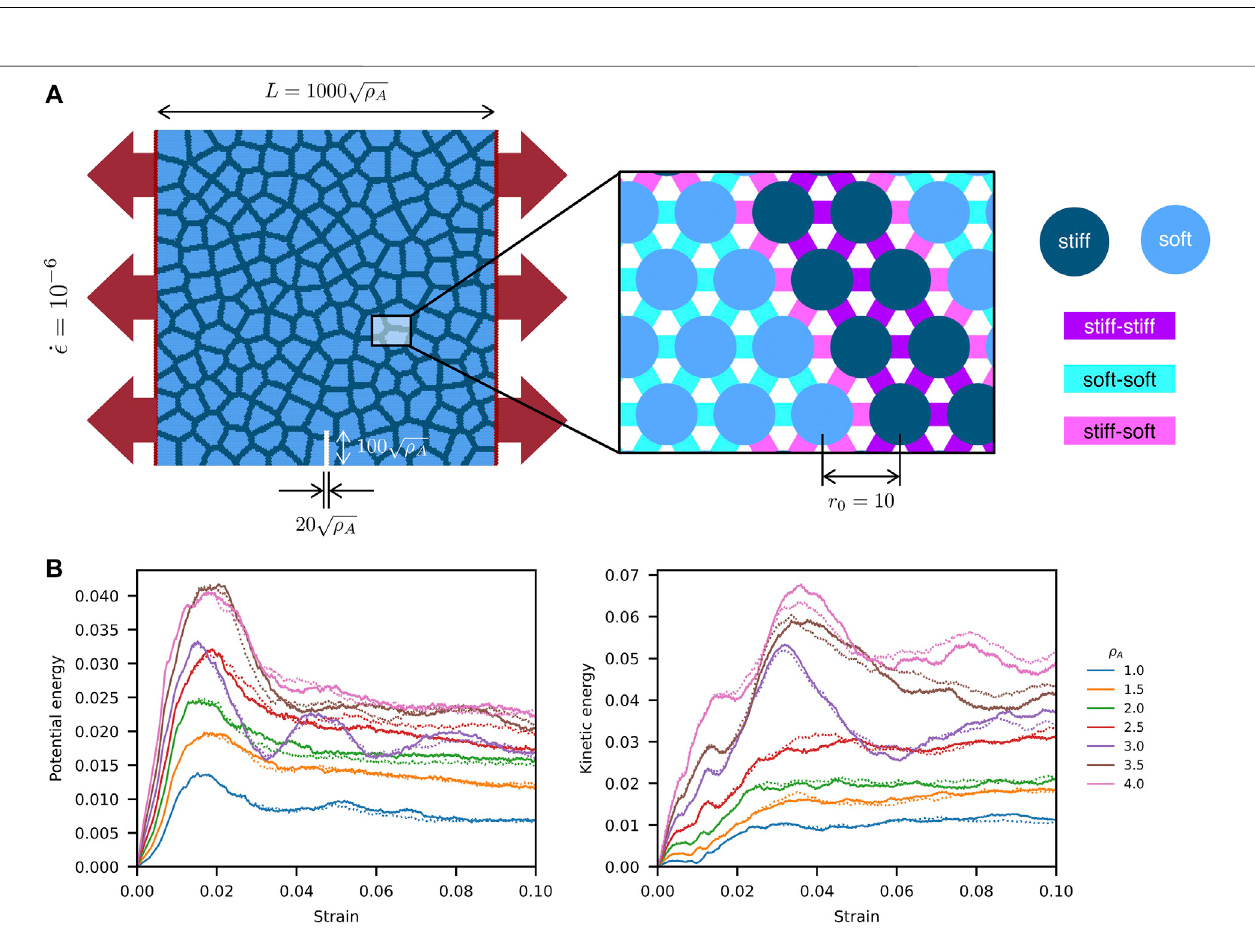
FIGURE 4 | Mode-I fracture simulation of Poisson composites by LSM. (A) Model size, notch size, and boundary conditions. Stiff-stiff, stiff-soft, and soft-soft springsareusedtomodelstiff,soft,andinterfacialmaterials. (B) PotentialandkineticenergiesofLSMswithdifferentarearatios ρ A rangingfrom1.0to4.0.Thesolidlines are computed by CuLSM, and the dashed lines are computed by LAMMPS.